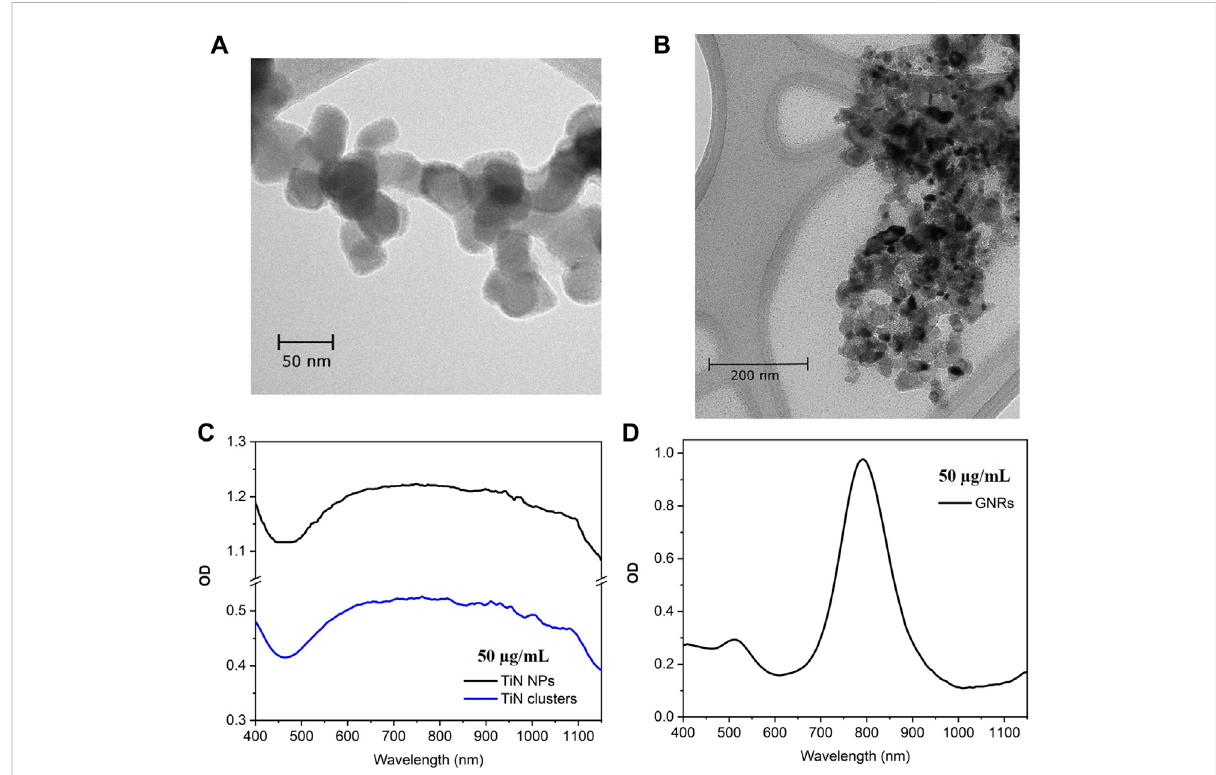
FIGURE 1 TEM micrographs and optical density (OD). (A) Commercial TiN NPs with cubic crystalline structure and average particle size of 50 nm. (B) TiN clustersfromNPsagglomerationusingreverseemulsionmethod,withaverageparticlesizeof300 nm. (C) ODspectrumofTiNNPsandTiNclusters centered at λ = 800 nm. (D) OD spectrum of GNRs with a plasmonic peak at λ = 808